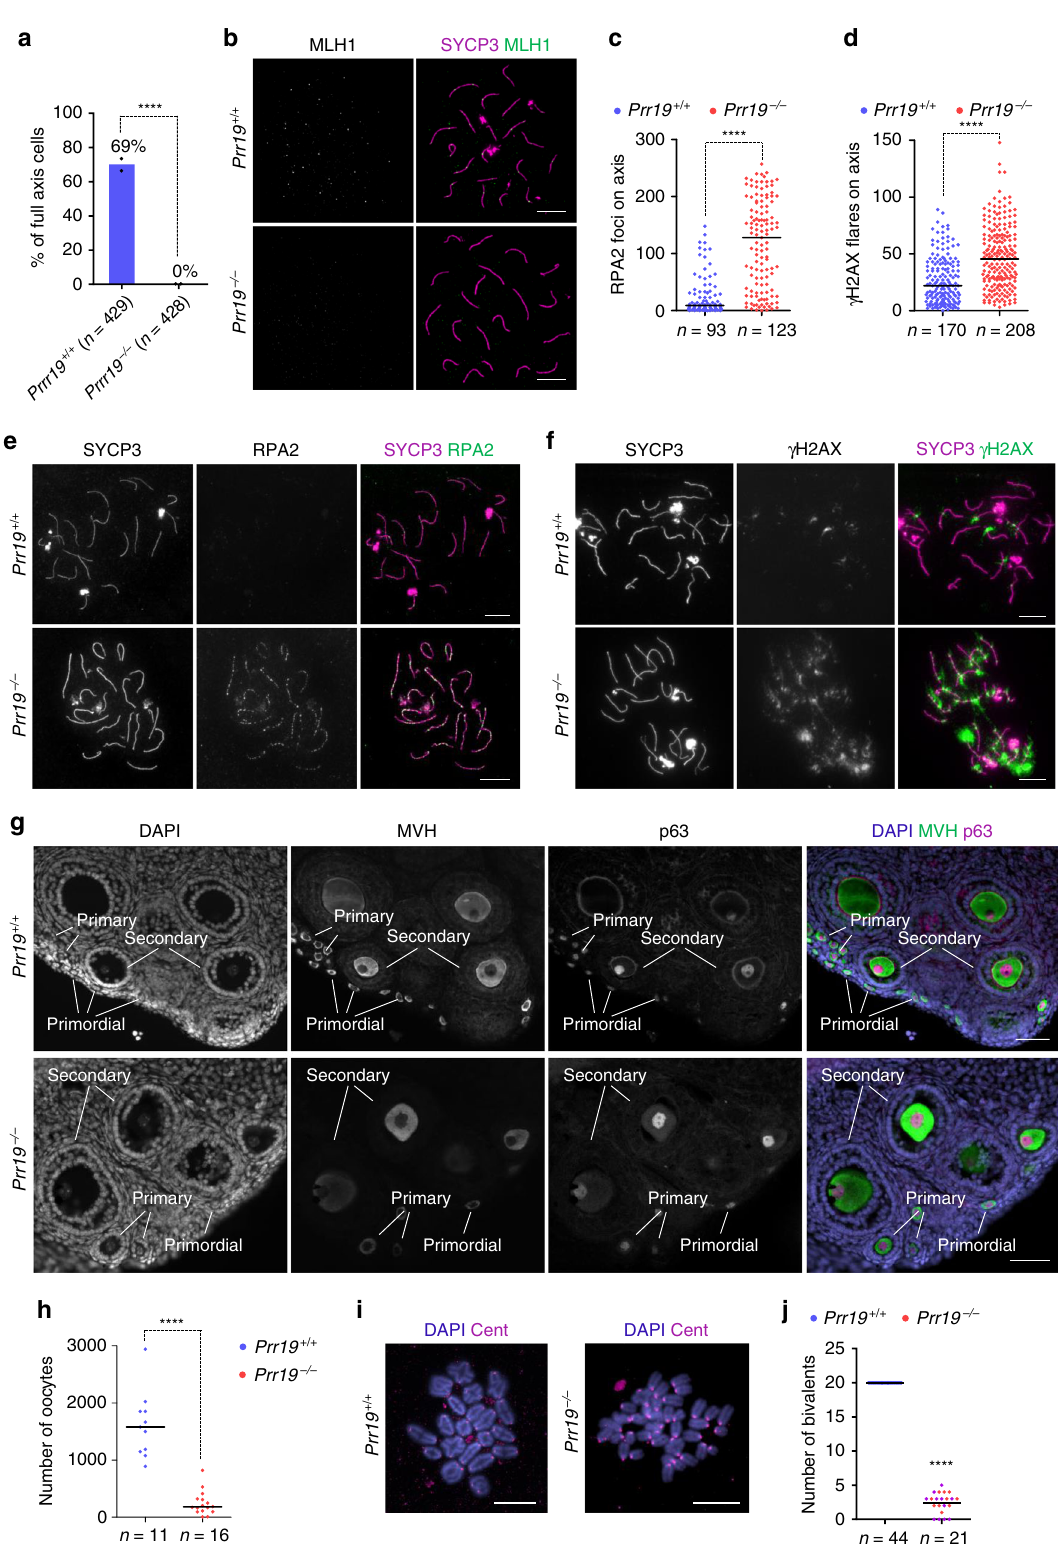
not detect HEI10 in PRR19 or CNTD1 immunoprecipitates (Fig. 7h), nor did HEI10 physically interact with PRR19 or CNTD1 in Y2H assays (Fig. 7i). We also noted marked differences between the meiotic phenotypes of Prr19 − / − and HEI10-de fi cient mice. Unlike HEI10, PRR19 is not required for bulk ubiquitin accumulation along chromosome axes (Supplementary Fig.